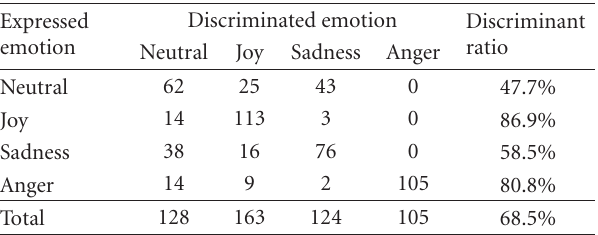
Table 4: Discriminant ratios of emotion (two-handed Finger Braille).